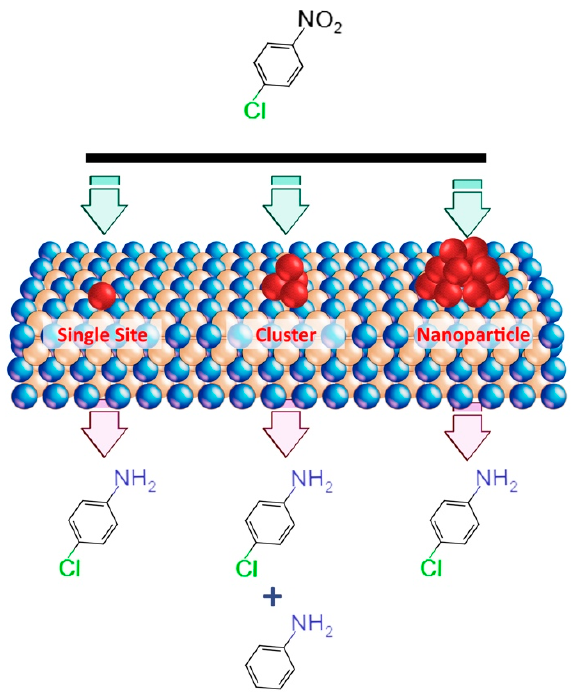
Figure 9. Selectivity change in para-chloronitrobenzene (p-CNB) hydrogenation to para-chloroaniline (p-CAN) and aniline, on selected Pt/CeO 2 catalysts with different Pt loadings.